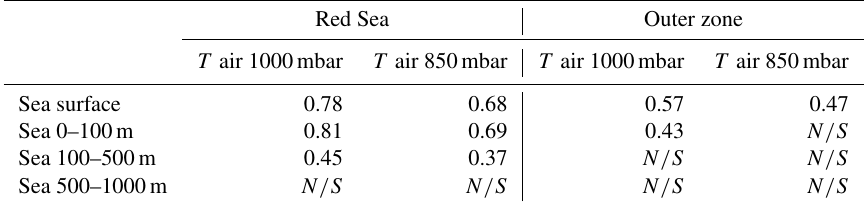
Table 2. Correlation between air and sea temperatures in the Red Sea and the Outer zone. Two heights are used for the air, 1000mbar, representative of the lower layers of the atmosphere in contact with the sea, and 850mbar, representative of the temperature in altitude (roughly 1450m height). Only years with averaged formal error below 0.15 ◦ C are considered. All values are significant at the 95% level ( N/S indicated